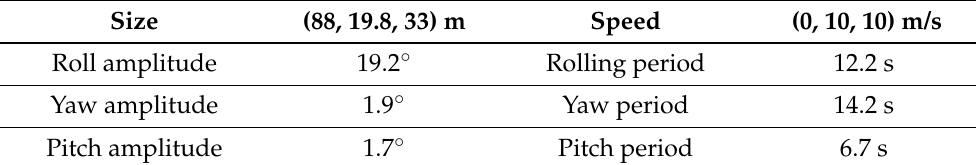
Table 2. Ship motion parameters.